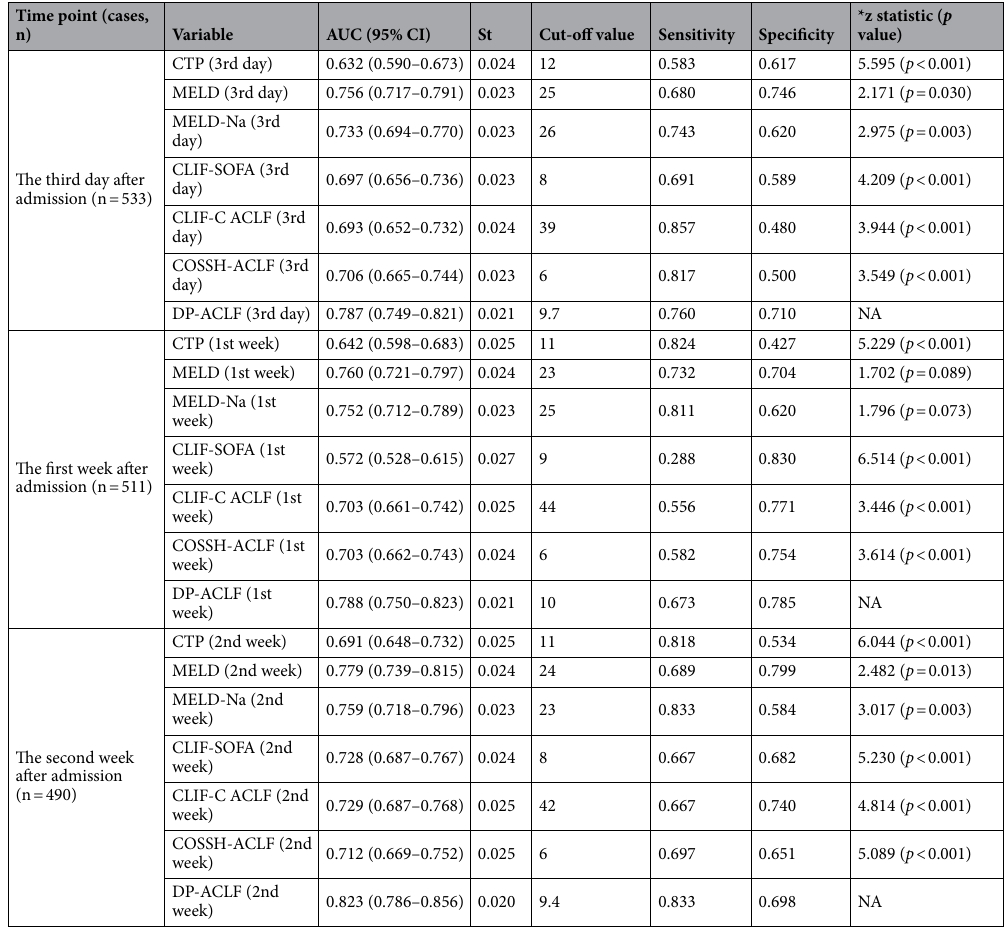
Table 4. Training group: ROC correlation analysis and comparison of DP-ACLF and other prognostic scores at the third day, first week and second week after